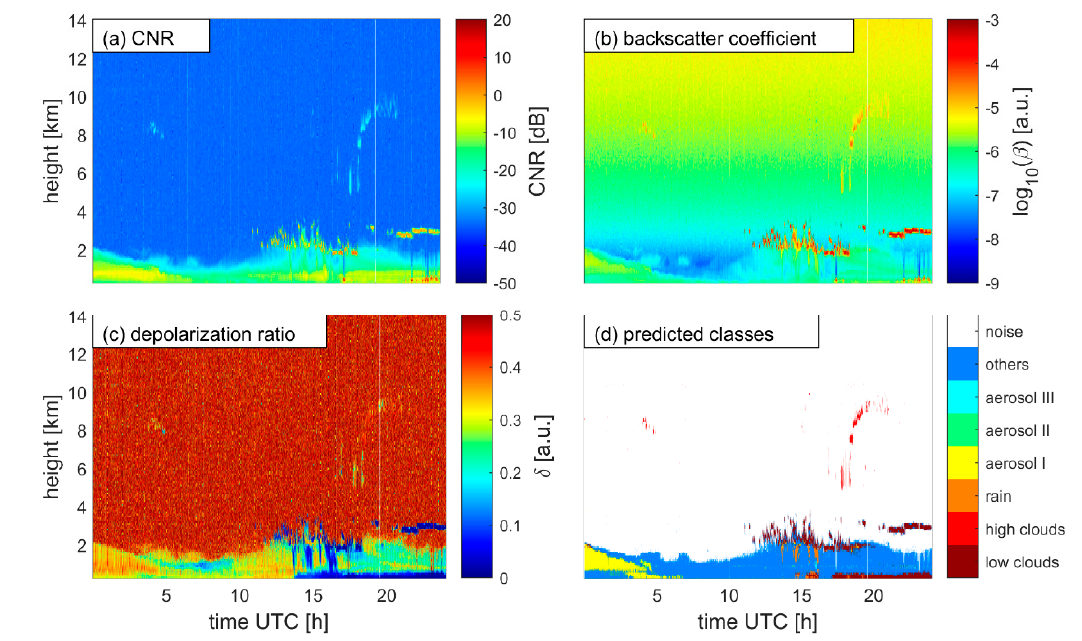
Figure 7. The lidar measurements on 15 June 2019, at Reykjavik ( a ) CNR, ( b ) backscatter coefficient, ( c ) depolarization ratio and the machine learning classification result ( d ) predicted classes.